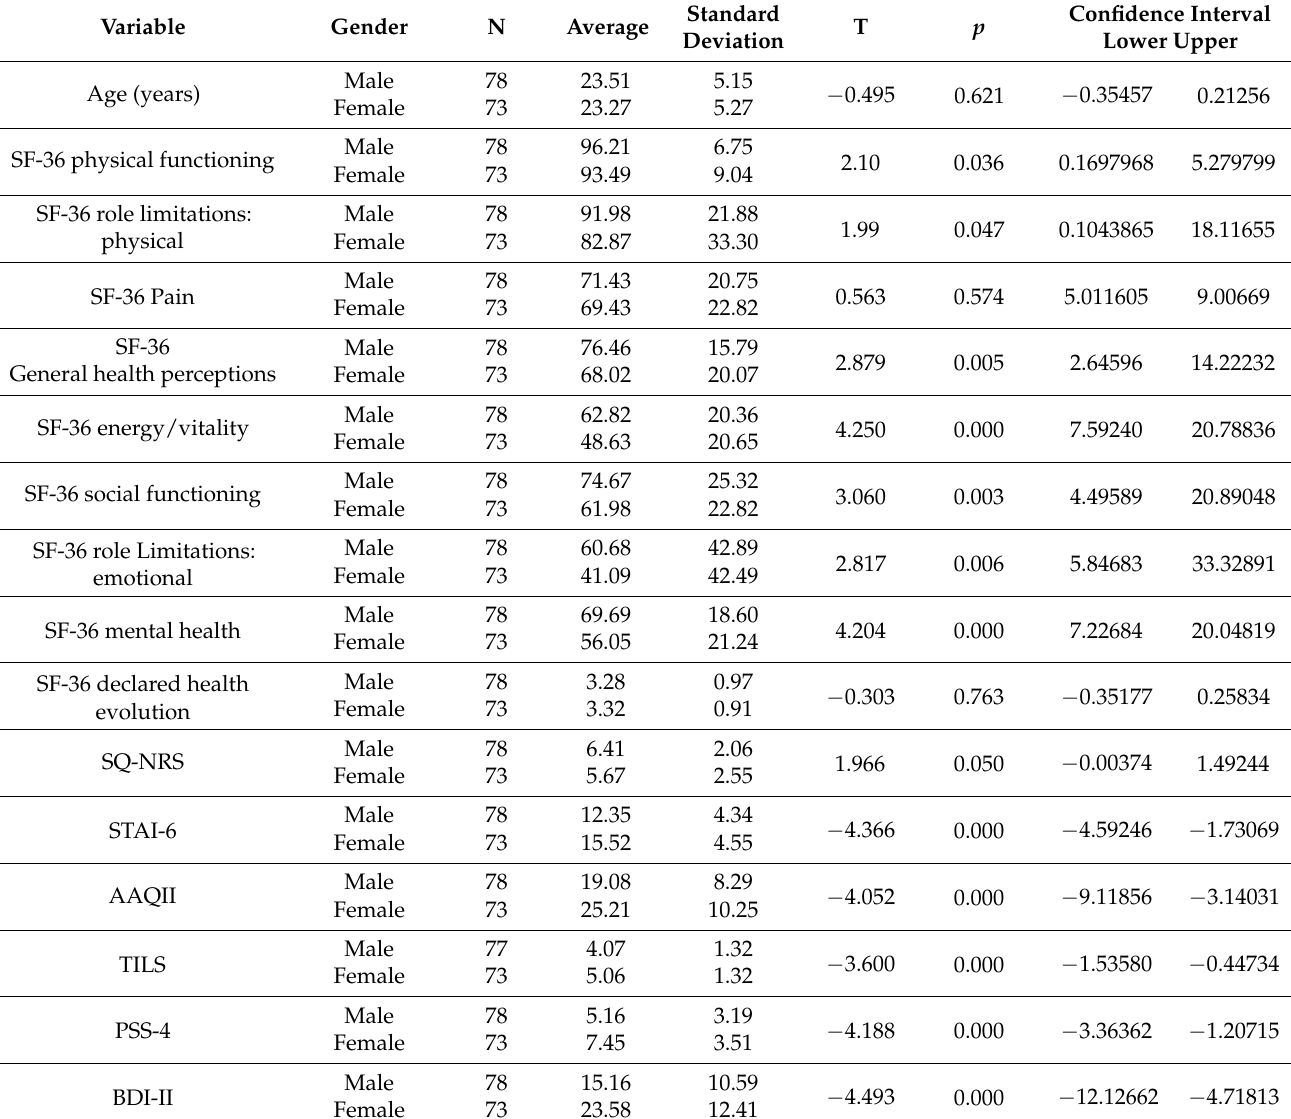
Table 1. Comparison between male and female